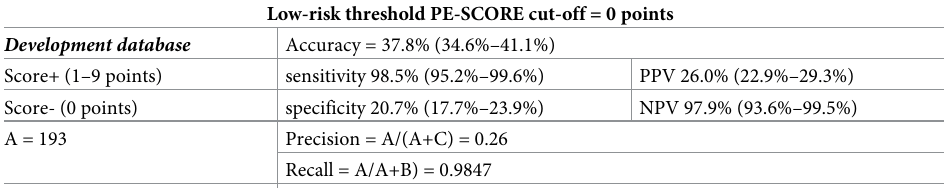
Table 6. Performance of PE-SCORE model at two risk thresholds on both